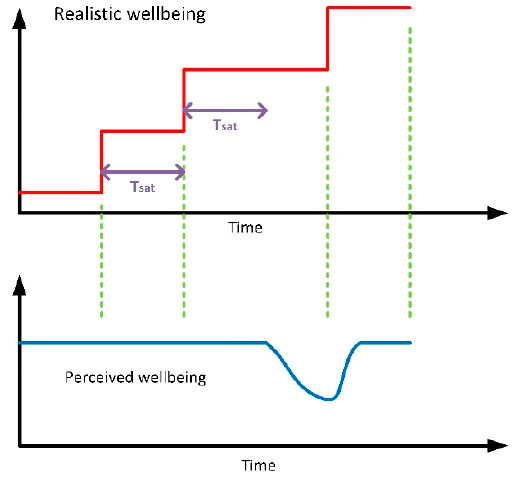
Figure 2. Relationship between realistic and perceived wellbeing.